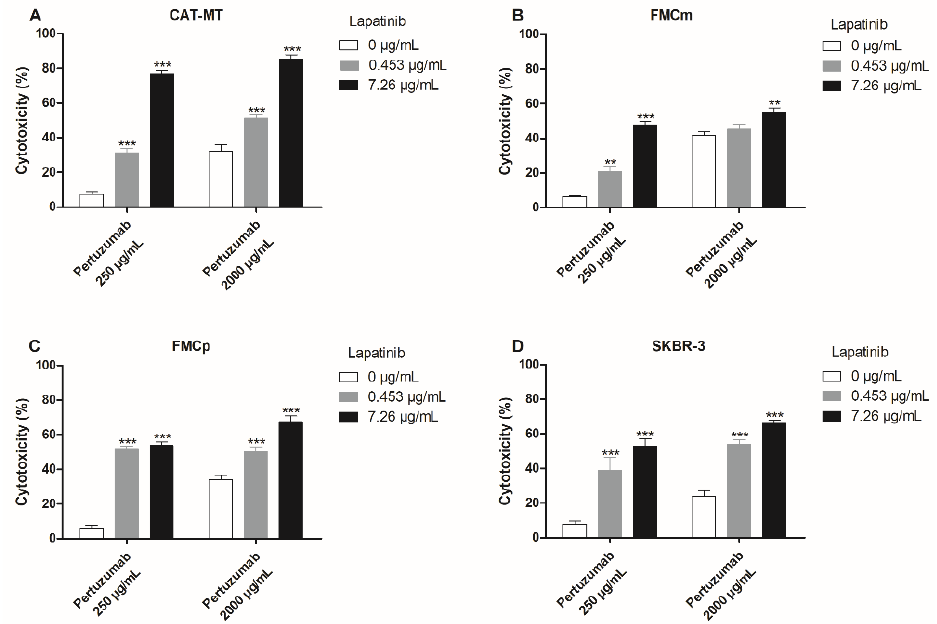
Figure 6. The combination of pertuzumab with lapatinib showed an improved antiproliferative effect in all the carcinoma cell lines. ( A ) CAT-MT cells presented synergistic antiproliferative effects for all the conjugations tested, the highest cytotoxic response occurring by the use of pertuzumab at 250 µ g/mL plus lapatinib at 7.26 µ g/mL, with 76.8% of cytotoxicity (*** p < 0.001). ( B ) The FMCm cells achieved the highest synergist effect, by the use of pertuzumab at 250 µ g/mL plus lapatinib at 7.26 µ g/mL, with 47.8% of cytotoxicity (*** p < 0.001), while the combination of pertuzumab at 2000 µ g/mL plus lapatinib at 7.26 µ g/mL presented a smaller cytotoxic effect (** p < 0.01). ( C ) The combination of pertuzumab at 250 µ g/mL plus lapatinib at 7.26 µ g/mL, in the FMCp cells, allowed to obtain 53.7% of cytotoxicity (*** p < 0.001). ( D ) As control, the human SKBR-3 cell line presented a synergistic effect for all the conjugations tested (*** p < 0.001). The experiments were performed in triplicates and repeated three separated times.